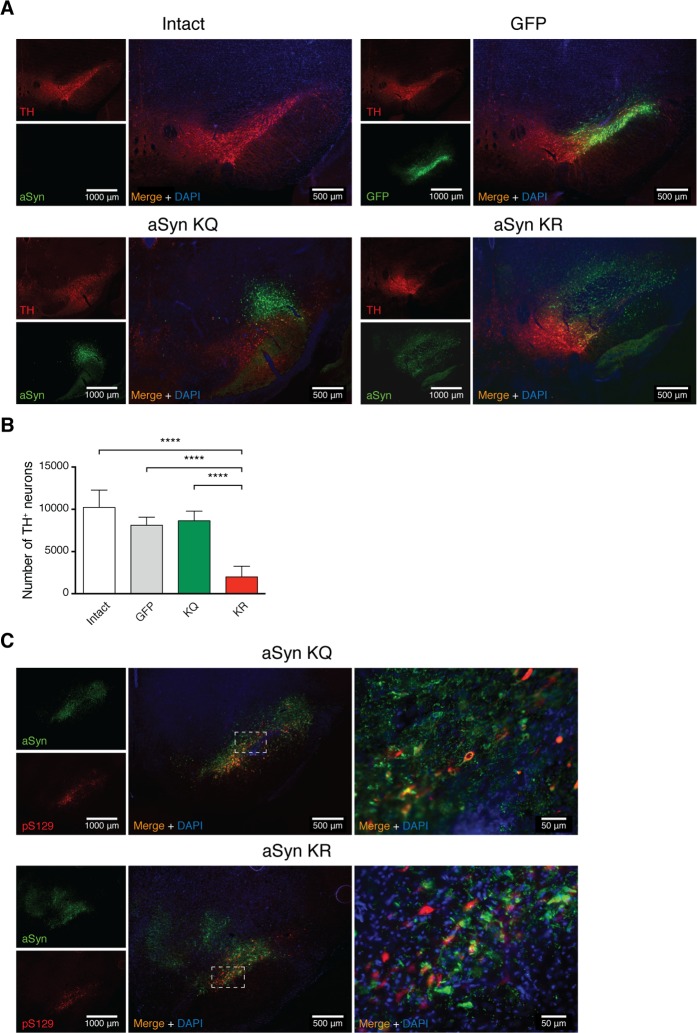
aSyn acetylation-resistant mutant induces nigral dopaminergic neuronal loss in vivo.(A) AAV6-mediated delivery of EGFP and mutant aSyn (KQ or KR) into the SN of the rat brain. TH and GFP or aSyn expression was examined in brain sections 3 wk after injection by immunohistochemistry (TH, red; GFP or aSyn, green; DAPI, blue). Representative sections are shown. Scale bar for isolated channels 1,000 μm and for merged channels 500 μm. (B) Stereological counting of the number of TH-positive neurons in the SN. The contralateral SN of the different groups of animals was used as a control (intact). Data in panels are average ± SD. (C) Brain sections stained for aSyn (green), pS129 aSyn (red), and DAPI (Blue). Representative sections are shown. Dashed square boxes delineate the magnification presented on the right. Scale bar for isolated channels 1,000 μm and for merged channels 500 μm and 50 μm. *** p < 0.001, **** p < 0.0001, one-way ANOVA with Bonferroni correction used for statistical calculations. In (B), GFP was used as a control; n = 6–7 animals per condition; five sections from a one-in-six series were analyzed per brain. Data in S1 Data.